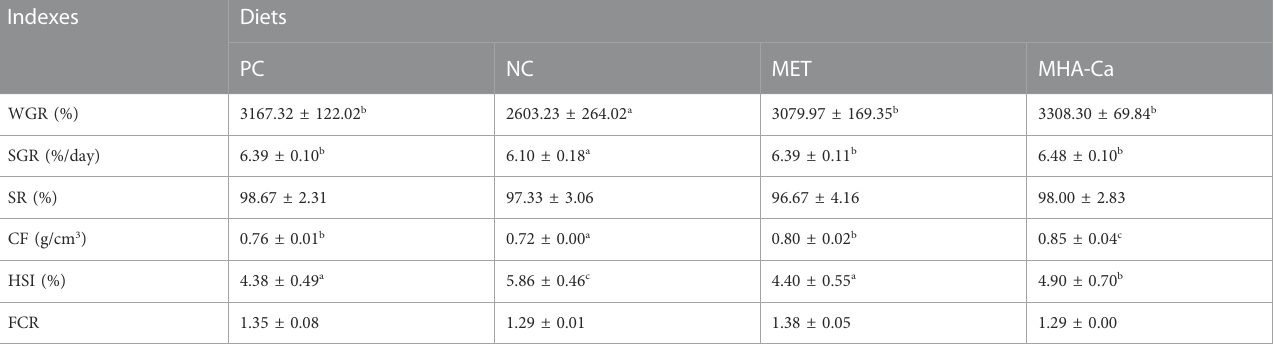
TABLE 4 Growth performance and feed utilization of L. vannamei fed the experimental diets. Indexes